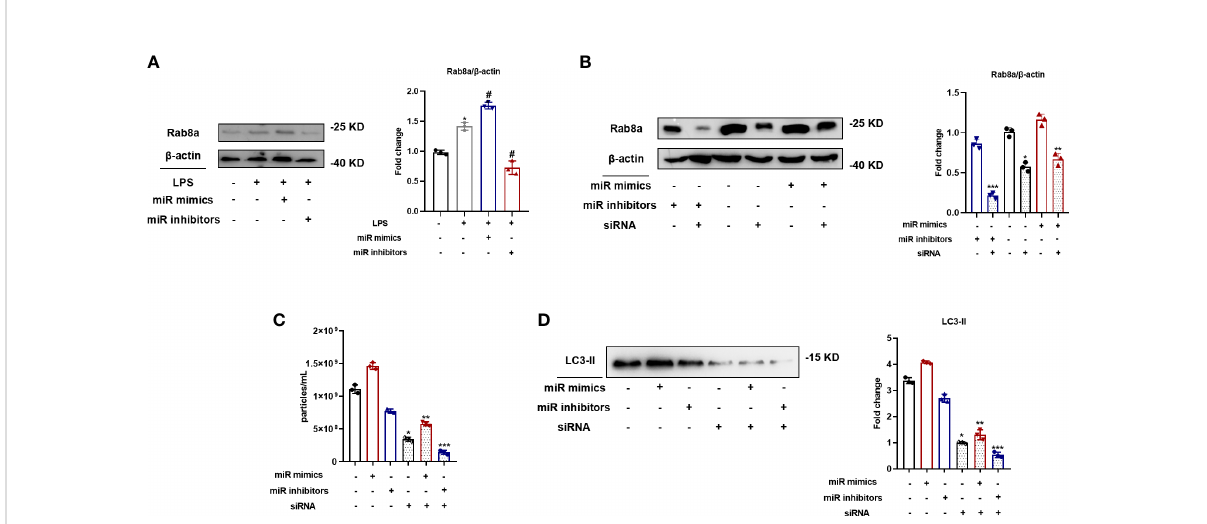
FIGURE 5 MiR-199a-3p mimicsaugmented LPS-induced SAP secretion via the activationof Rab8a in vitro . (A) Western blotanalysis demonstrated the Rab8a levels in RAW264.7 cells with the transfection ofMiR-199a-3p mimicsor inhibitors. (B) Westernblot analysisillustratedthe ef fi cient siRNA-mediated knockdown of Rab8a inRAW264.7 cells with the transfection ofMiR-199a-3p mimicsor inhibitors. (C) NTA revealed signi fi cant decreases in vesicle levels fromRAW264.7 cells with Rab8aknockdown in the MiR-199a-3p mimic and inhibitor groups compared with the control group. (D) Western blot analysis demonstrated signi fi cant decreases in LC3-II levels in vesicles fromLPS-stimulated RAW264.7 cells in the Rab8a knockdown groups compared with the control group. The experiments wererepeated at least three times (n= 3 per group). Each value represents the mean ± SD ofthree independent experiments. *p< 0.05 vs . the control; #p< 0.05 vs . the LPS control; **p < 0.05 vs . the mimicsgroup without Rab8a knockdown; ***p< 0.05 vs . the inhibitors group without Rab8aknockdown, one-way